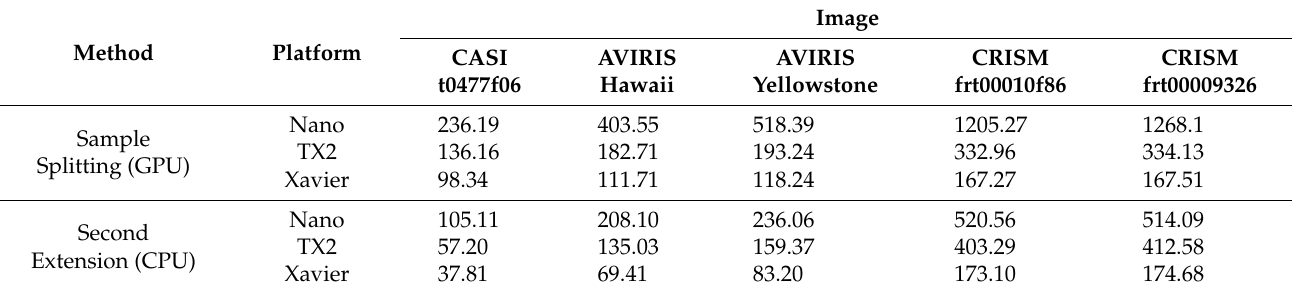
Table 4. Detailed execution times for the parallel block adaptive entropy encoder in